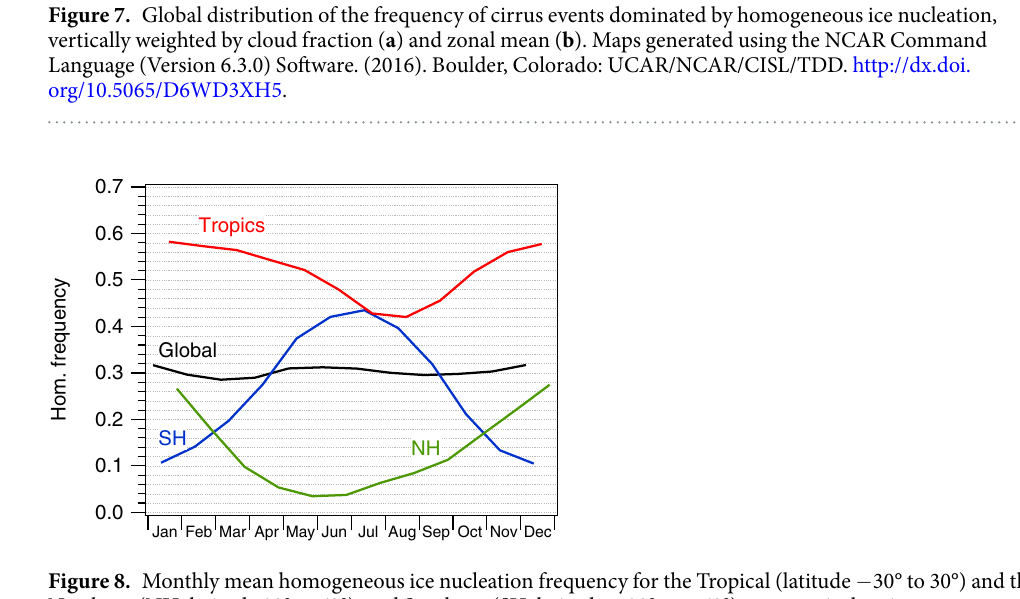
Figure 8. Monthly mean homogeneous ice nucleation frequency for the Tropical (latitude − 30° to 30°) and the Northern (NH, latitude 30° to 60°), and Southern (SH, latitude − 30° to − 60°) extratropical